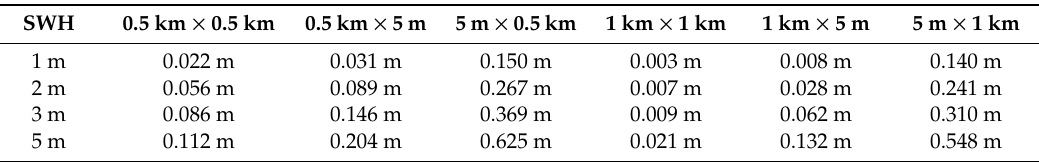
Table 9. The RMS of smoothing velocity bunching height inversion results with di ff erent significance wave height (SWH) (the direction of the smoothing window is in two directions at the same time, in the azimuth and in the range).